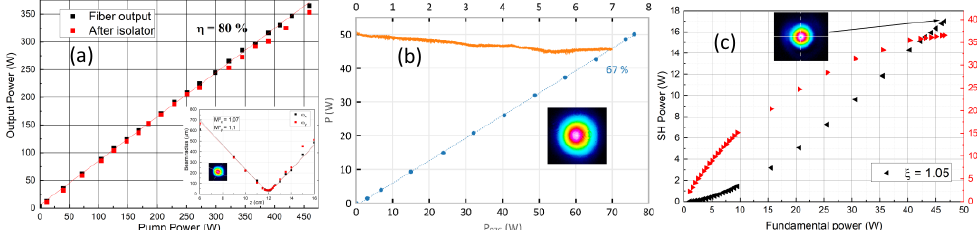
Fig. 1. (a): high power 1064nm MOPA, output power versus pump power at the fiber output (black) and after the isolator (red), M 2 (inset)(b): 1013 nm laser power vs pump power and slope efficiency (blue), 7-hour stability (orange) and mode profile (inset) (c) 1064/532 Second harmonic single pass generation SH power (black) and efficiency (red) versus fundamental power and mode profile (inset). Another interesting case laying in the lower side of the Yb doped fiber operation window is 1013nm.